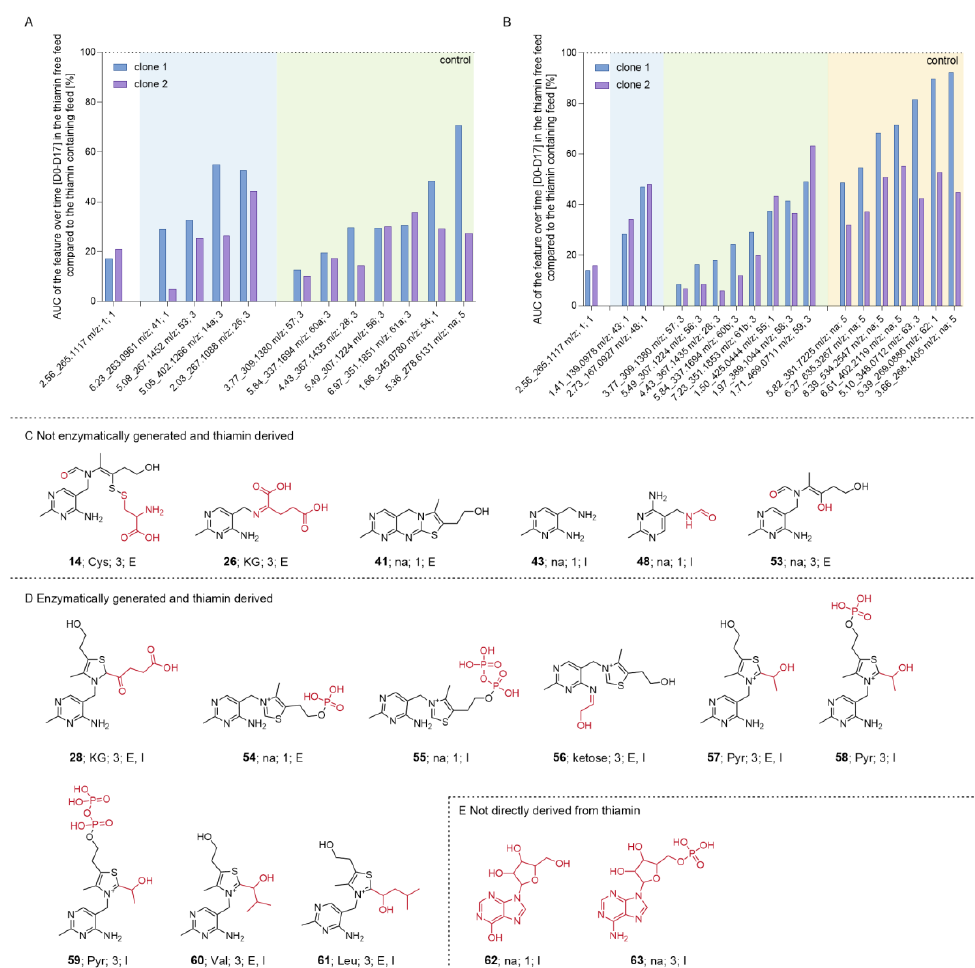
Figure 6. Extra- and intracellular metabolomics applied to supernatant or CHO cell lysates during a FB experiment. Area under the curve of ( A ) extra- or ( B ) intracellular interesting feature abun- dance over time (days 0 – 17) of thiamin-free feed conditions normalized to the control condition for clone 1 and 2. Tier 1- and 3-identified interesting features clustered in ( C ) not enzymatically or ( D ) enzymatically generated and thiamin-derived and ( E ) not thiamin-derived groups. For 60 and 61 , Val and Leu were presented as interaction partner. Component specific information are presented as [ Identifier ; interaction partner if found or not available (na); tier level; detected extra- ( E ) or intracellularly (I)]. Red highlights structural differences compared to